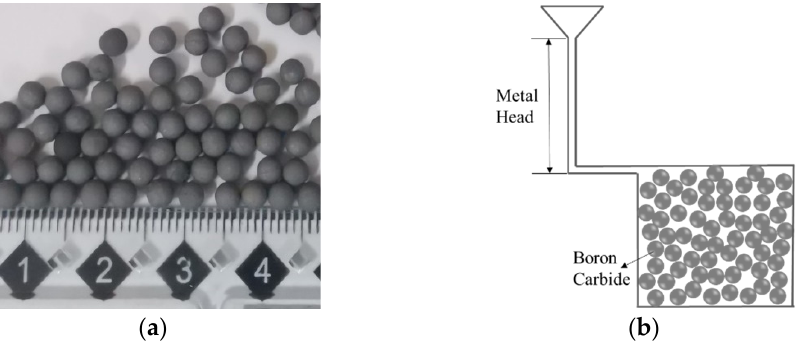
Figure 2. Boron carbide particles and casting process. ( a ) B 4 C particles with average 1.5 mm radius, ( b ) schematic diagram of infiltration casting.